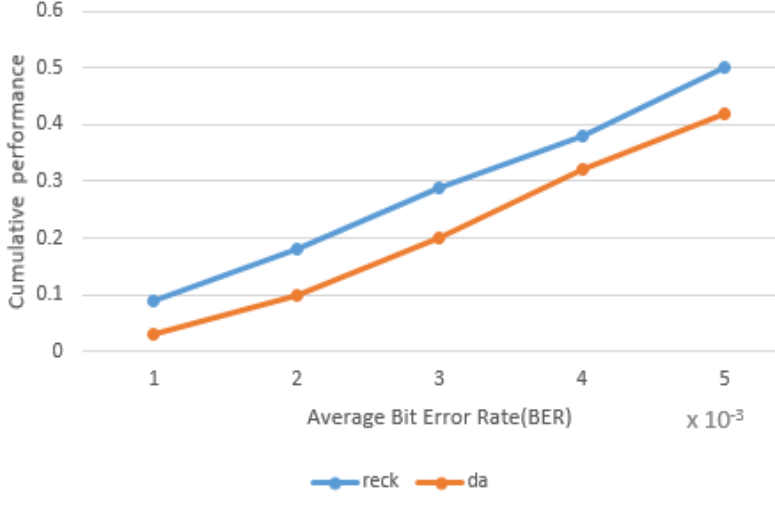
Figure 4. Comparative analysis of DA and RECK algorithm in the context of average bit error rate